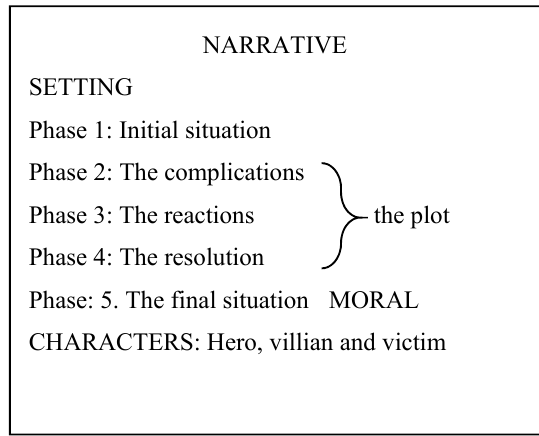
Figure 1. The sequence of phases and features of a narrative (Source: Adam, 2008) [4].